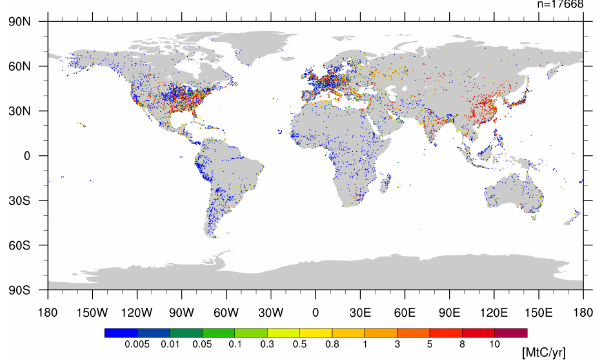
Fig. 1. Global spatial distributions of power plant emissions for the year 2007. The coordinate and emission data of power plants were taken from the CARMA database (CARbon Monitoring and Action, http://carma.org/). Power plant data with invalid coordinate information and no CO 2 emissions were excluded, and the 17,668 power plants incorporated into our inventory were plotted. Values are given in units of Megatonne carbon year − 1 .